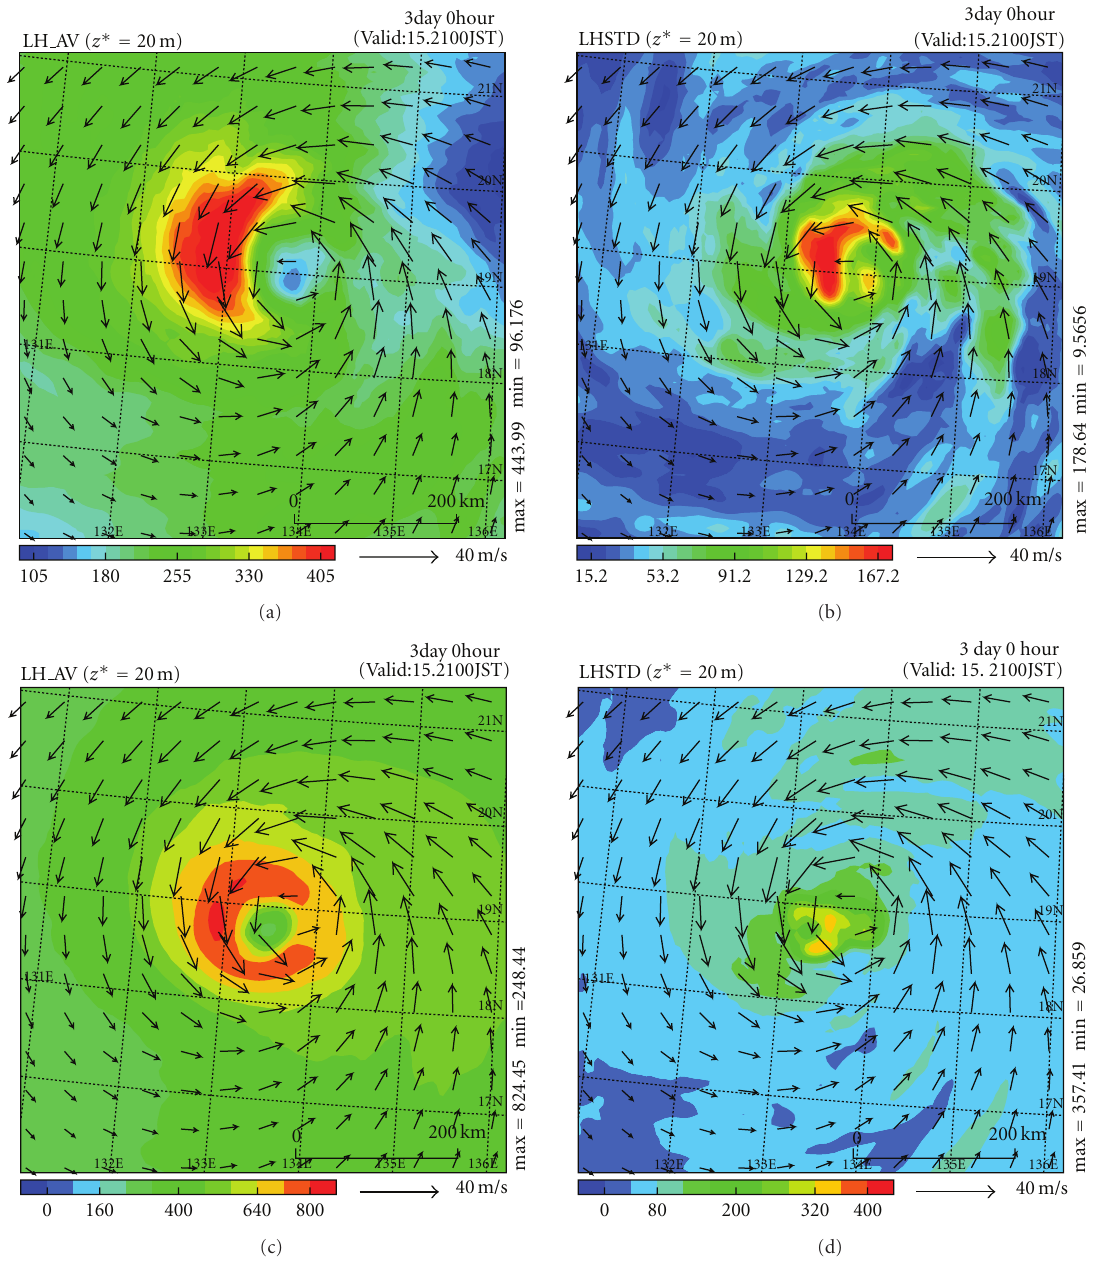
Figure 10: (a) Horizontal distribution of mean latent heat flux (Wm − 2 ) at 72 h averaged over the nine NCM predictions and (b) that of the standard deviation at 72 h in NCM; (c) and (d) are the same as (a) and (b), respectively, except that they show the NHM results. Mean horizontal wind field vectors at 72 h averaged over the nine NCM (in parts (a) and (b)) and NHM (in parts (c) and (d)) predictions are also shown in each